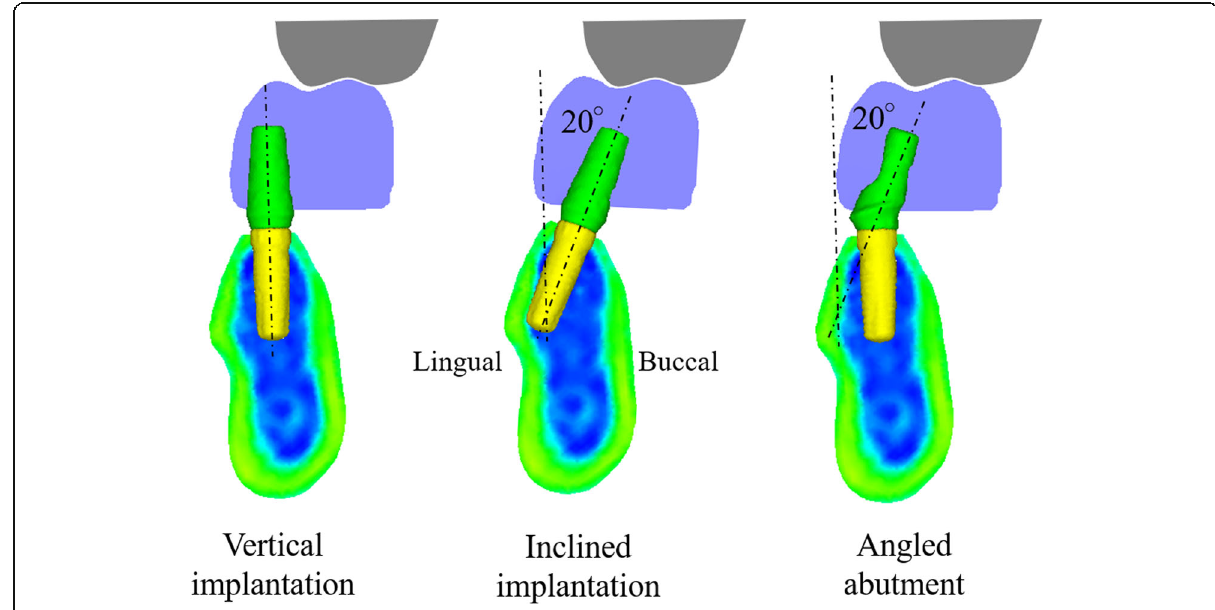
Fig. 9 Three models under conditions of HL2/VL2